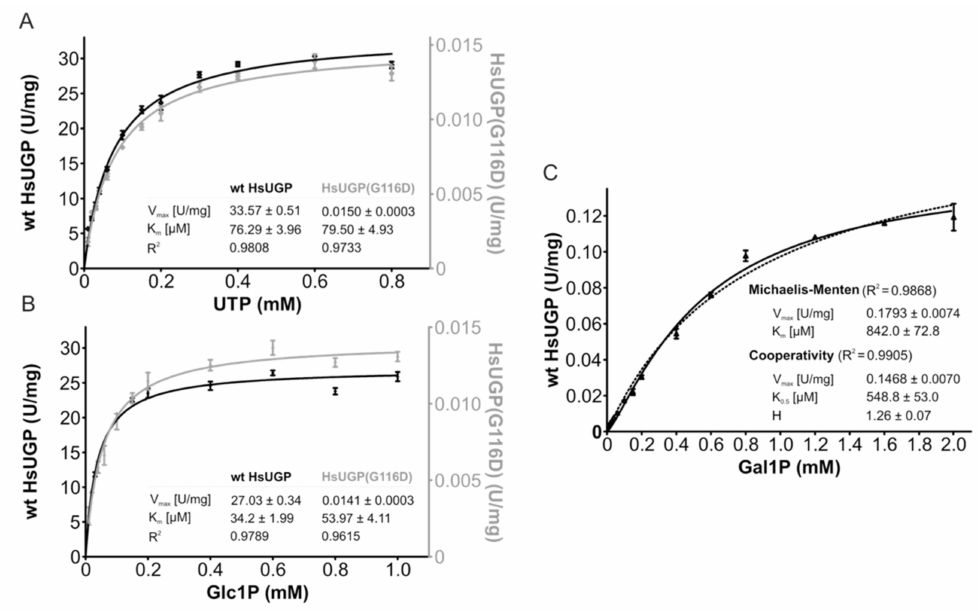
Figure 8. Enzymatic activity and kinetic parameters of recombinant wild-type HsUGP and HsUGP(G116D). ( A , B ). In vitro activity of recombinant purified wild-type HsUGP (black) and HsUGP(G116D) (grey) as a function of UTP ( A ) or Glc1P ( B ) concentration. ( C ). In vitro activity of recombinant purified wild-type HsUGP as a function of Gal1P concentration (activity of the G116D variant with this substrate was not detectable). Data points represent the mean of six determinations. Curve fitting according to the Michaelis–Menten model ( A – C ) or the cooperativity model ( C ) and determination of kinetic parameters (reported in the insets as the means +/ − standard errors of the means) were performed in GraphPad Prism